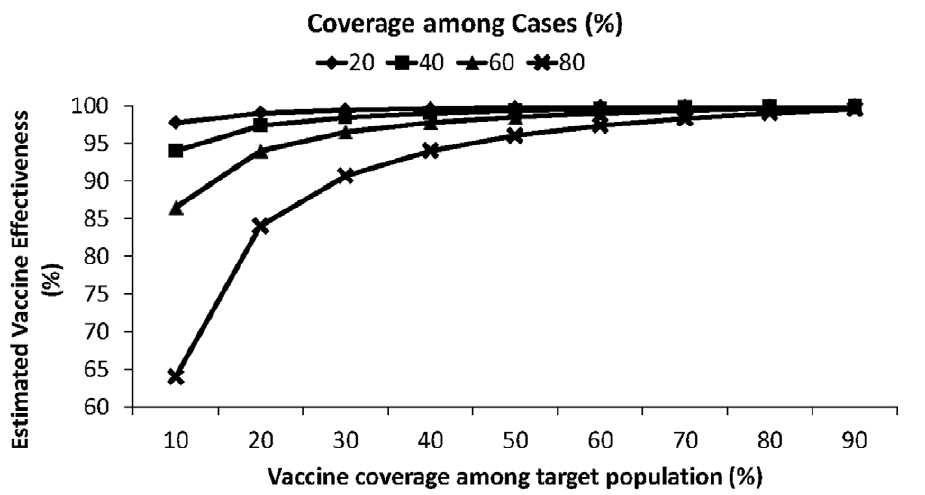
Figure 1. Estimated vaccine effectiveness using the screening method. This figure was created using hypothetical data created by the authors, and is adapted from a similar figure in Orenstein, et al. (1985) [4]).